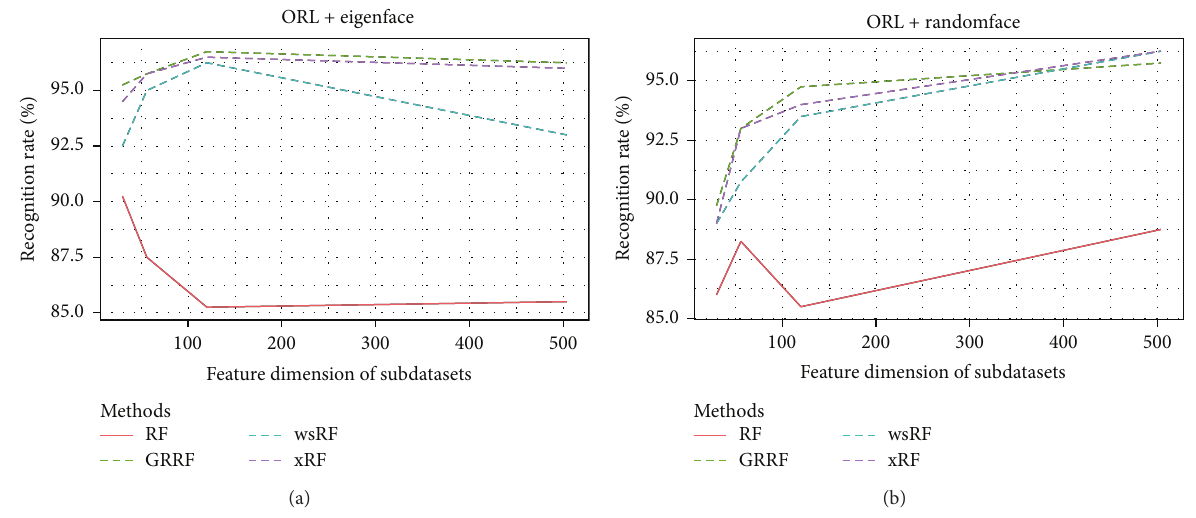
Figure 2: Recognition rates of the models on the ORL subdatasets, namely, ORL.EigenfaceM30, ORL.EigenM56, ORL.EigenM120, ORL.EigenM504, and ORL.RandomfaceM30, ORL.RandomM56, ORL.RandomM120, and